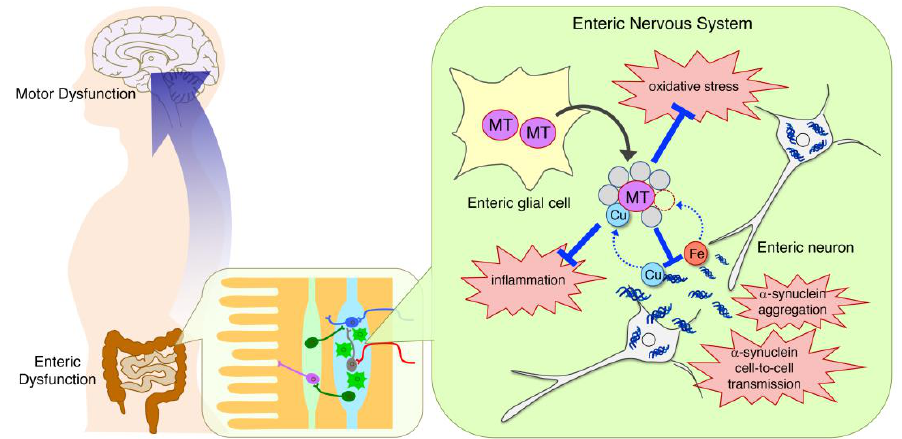
Figure 3. Neuroprotective functions of MTs in the ENS. MT1/2 are expressed in enteric glial cells and secreted extracellularly. In the extracellular space, MTs ameliorate oxidative stress and inflammation. In PD, aggregated α-synuclein is released from neuronal cells and undergoes cell-to-cell propagation in a prion-like fashion. The α-synuclein aggregates are taken up by neighboring cells and further promote α-synuclein aggregation and propagation. MTs chelate metals and prevent metal-induced α-synuclein aggregation and cell-to-cell transmission. Therefore, MTs’ upregulation in the ENS could be a potent therapeutic strategy to inhibit the initial enteric pathogenesis and progression of PD.